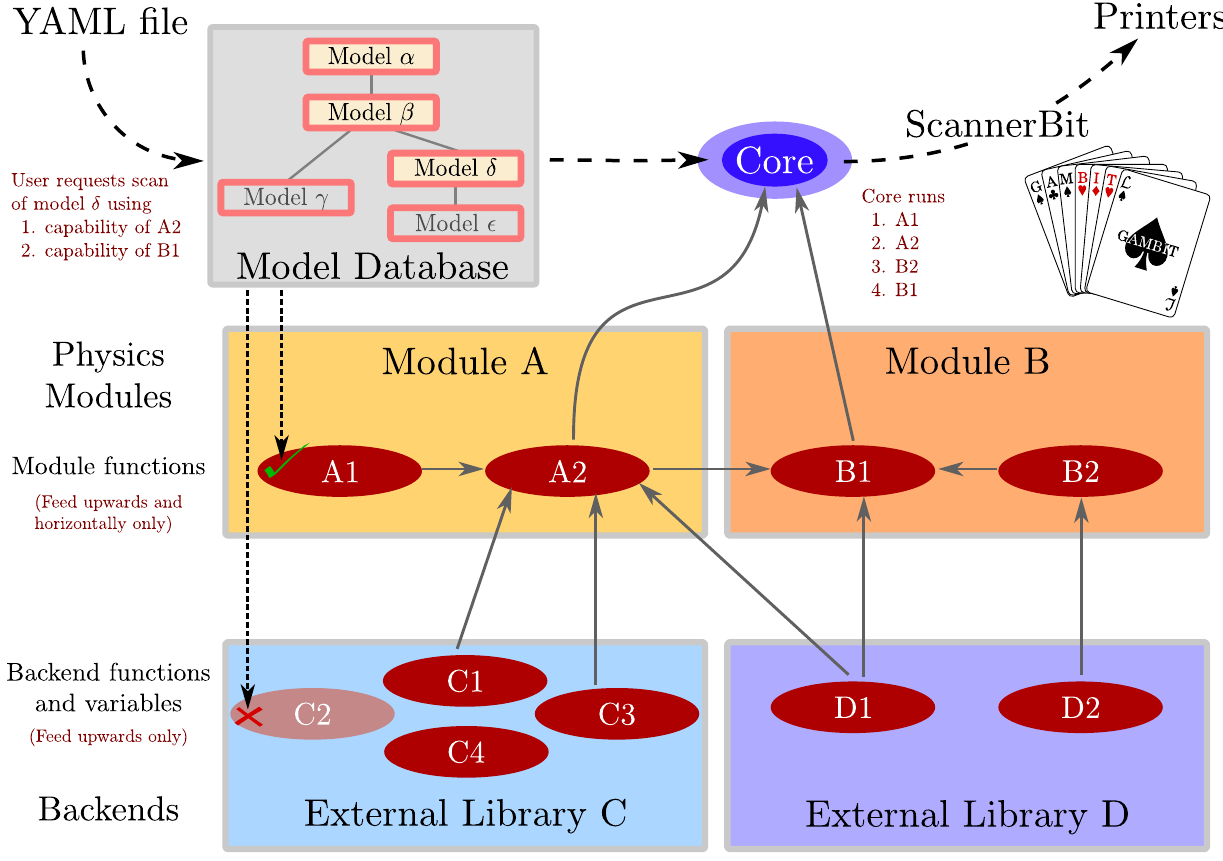
Fig. 1 A schematic representation of the basic elements of a GAM- BIT scan. The user provides a YAML input file (see www.yaml.org), which chooses a model to scan and some observables or likelihoods to calculate. The requested model δ and its ancestor models (see text for definition) β and α are activated. All model-dependent module and backend functions/variables are tested for compatibility with the acti- vated models; incompatible functions are disabled (C2 in the example). Modulefunctionsareidentifiedthatcanprovidetherequestedquantities (A2 and B1 in the example), and other module functions are identified